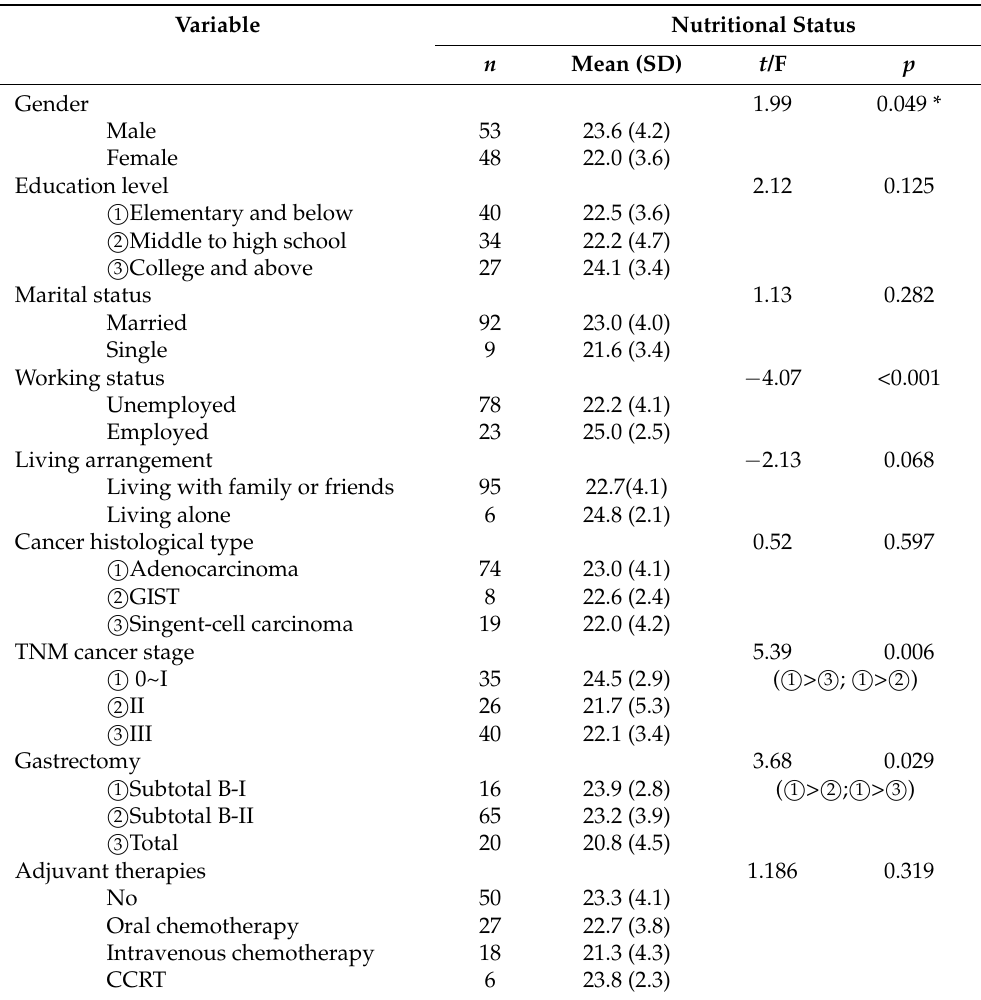
Table 3. Differences in nutritional status among patients with different demographics and disease profiles ( n = 101).